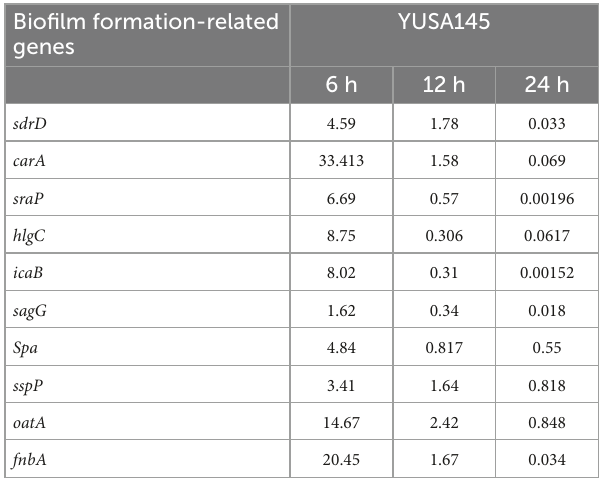
TABLE 4 The RNA expression levels of biofilm-related genes in S. aureus YUSA145 treated with radezolid. Biofilm formation-related